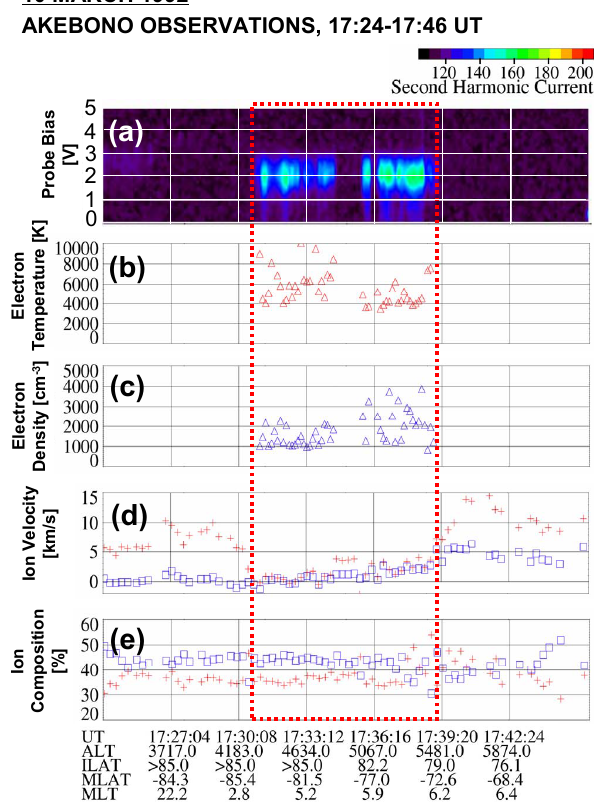
Fig. 1. (a) Probe voltage versus time spectrogram of second har- monic current, (b) electron temperature, (c) electron density on 10 March 1992 derived from TED observations; see text for de- tailed relationship between the measured current and the electron energy distribution, (d) Parallel drift velocities (positive upward) of H + (red) and O + (blue) ions derived from SMS observations, and (e) H + (red) and O + (blue) fraction of total ion density; the red dashed lines denote the high plasma density region.